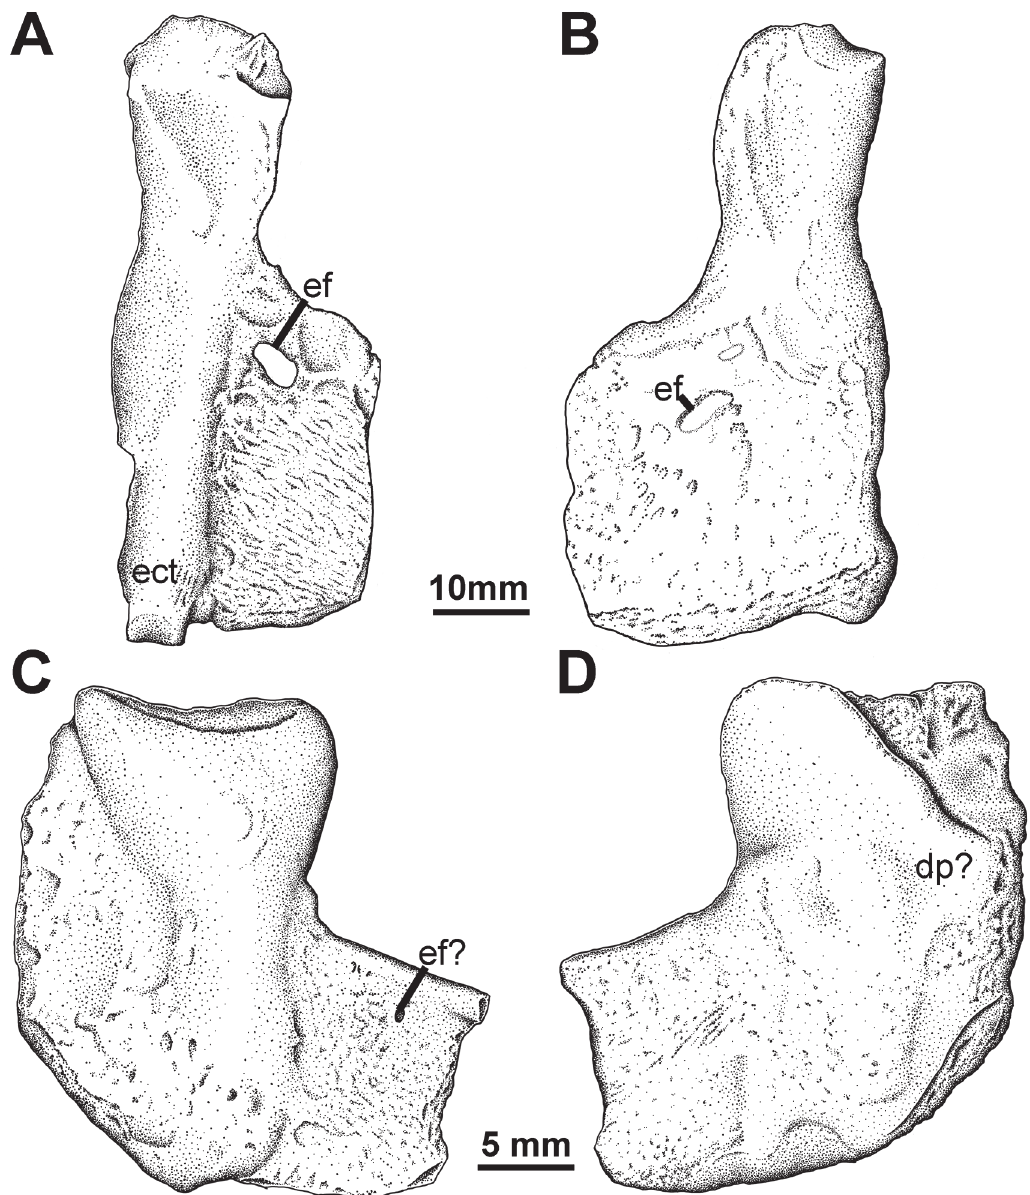
Fig 6. Humerus Types 2 and 3. YPM PU 20754, left humerus in A, dorsal; and B, ventral views, less areas still obscured by matrix. RM 20.6770 left? humerus in C, dorsal, and D, ventral, views. Abbreviations : dp , deltopectoral crest; ect , ectepicondyle; ef , entepicondylar